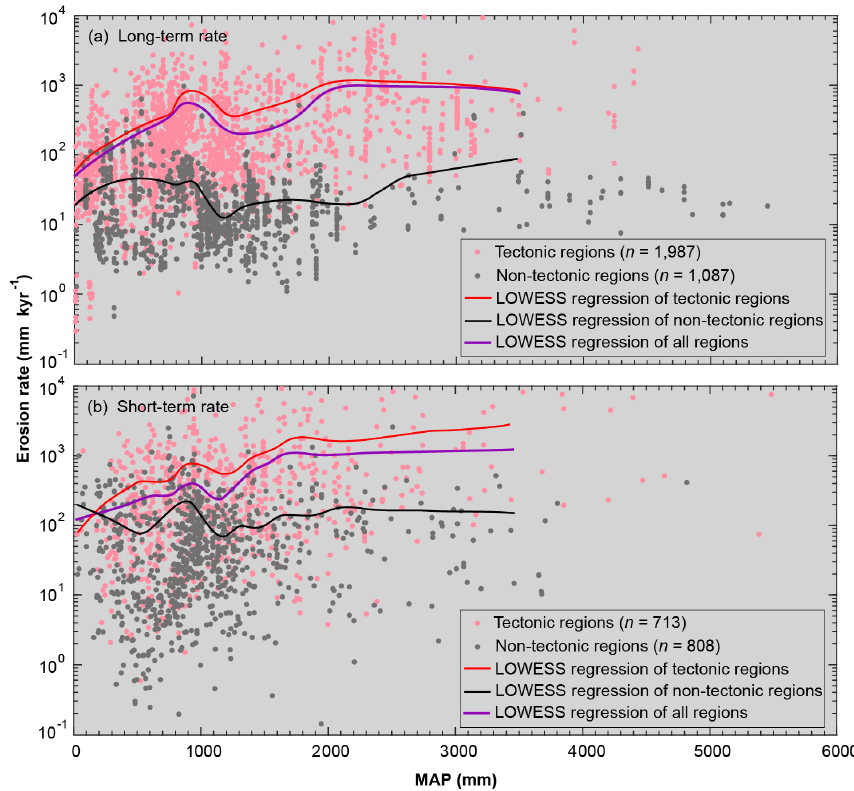
Figure 5. Relationships between mean annual precipitation (MAP) and long- (a) and short-term (b) erosion rates split into tectonic (pink) and non-tectonic (grey) regions. The red curve is the LOWESS regression for erosion versus MAP in tectonic regions, the black curve is the LOWESS regression for erosion versus MAP in non-tectonic regions, and the purple curve is the LOWESS regression for erosion versus MAP across all regions. The regressions are truncated at extremely humid regions (MAP > 3500mm) owing to the limited number of data in these